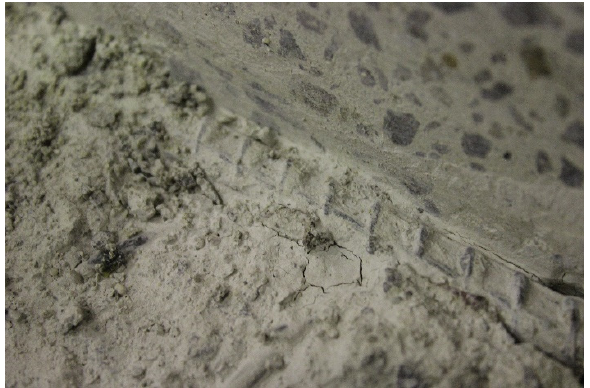
Figure 11. Steel–concrete interface on the OPC beam, showing cracks along the ribs and crushed concrete between ribs.